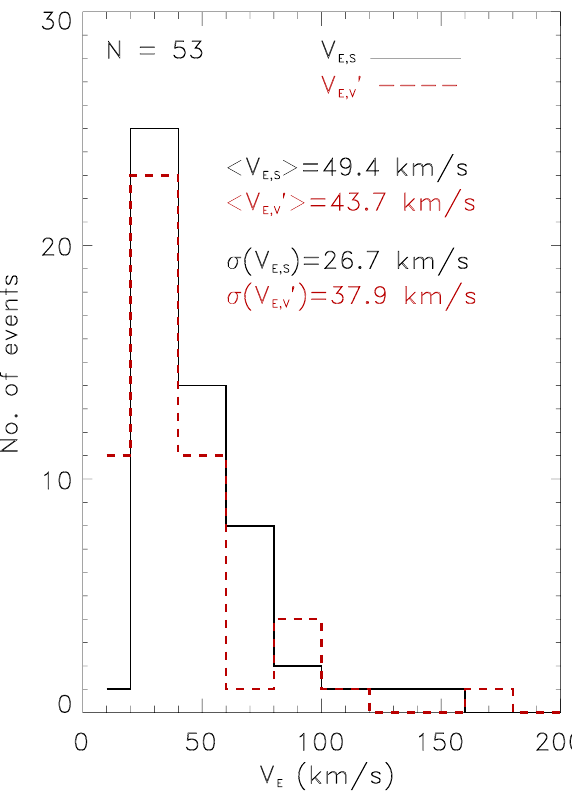
Fig. 7. Histograms of the values derived for V E,S (black) and V 0 E,V (in red) based on Eqs. (5) and (9), respectively, and where the lat- ter is based on [ | V Z, CL (MAX) | , | V Z, CL (MIN) | ], separated by 1t 0 ]. The peaks for both are at 30km/s for bucket widths of 20km/s and the averages and standard deviations ( σ) are shown for the two sets. (Note that there is one value of V 0 of 213km/s that occurs off- E,V scale and therefore is not